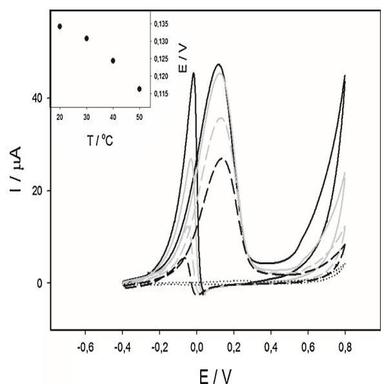
Cycle voltammograms of the electrocatalytical oxidation of 0.5 M ethanol in 0.1 M NaOH registered at filtering paper covered with PPy–Au composite at different temperatures. Black solid line – 50 °C, grey solid line – 40 °C, grey dashed line – 30 °C, black dashed line – 20 °C, dotted line - background. Scan rate: 20 mV/s. Inset: E peak vs temperature.